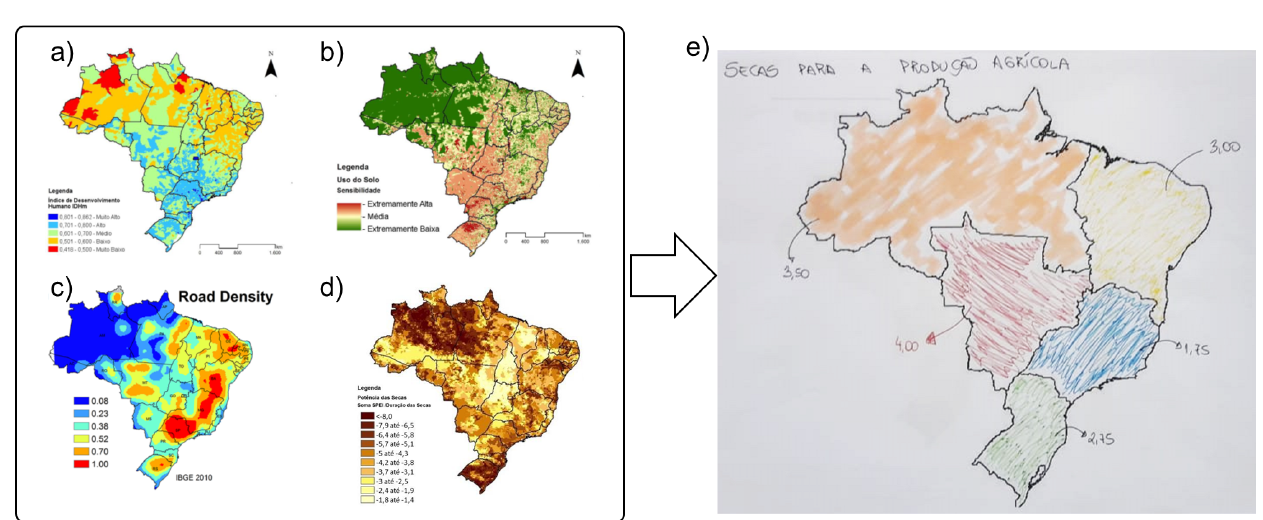
Figure A8. Package of maps used in the second training for mapping climate risk associated with agricultural droughts. The maps illustrate (a) Human Development Index (HDI; MMA, 2017), (b) land use (MMA, 2017), (c) road density (Debortoli et al., 2017), (d) drought potential (MMA, 2017), and (e) the climate risk map drawn by the participants.